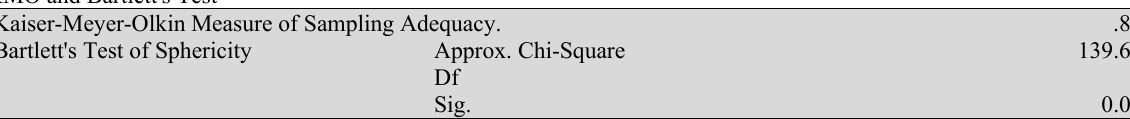
KMO and Bartlett's Test Kaiser-Meyer-Olkin Measure of Sampling Adequacy. .830 Bartlett's Test of Sphericity Approx. Chi-Square 139.625 Df 15 Sig. 0.000 (Source: The survey data of the